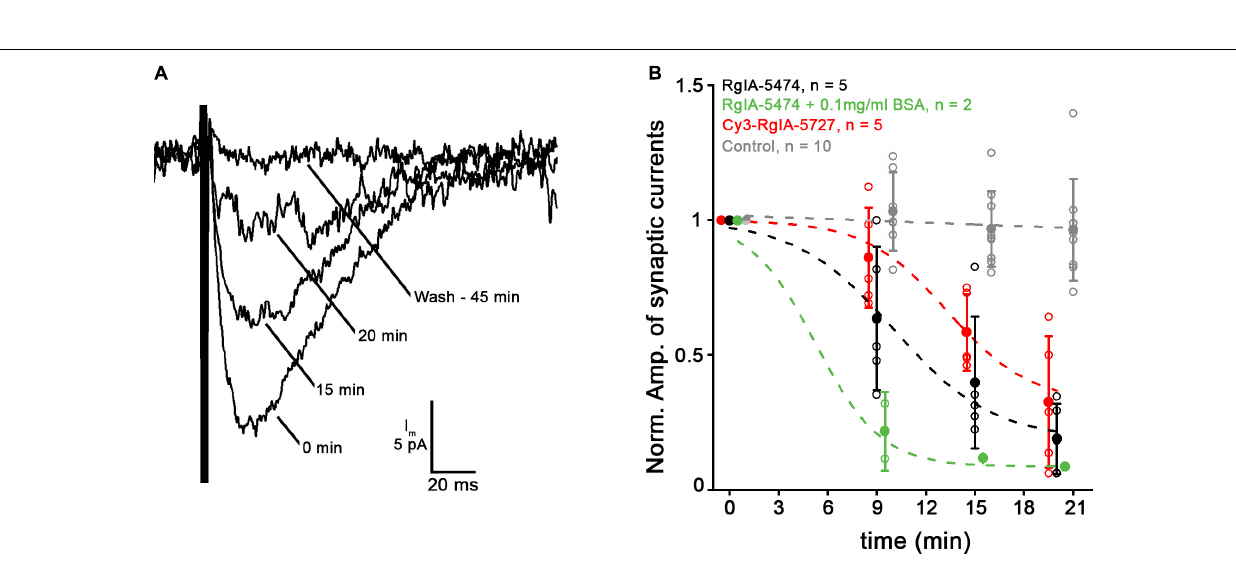
Frontiers in Cellular Neuroscience |